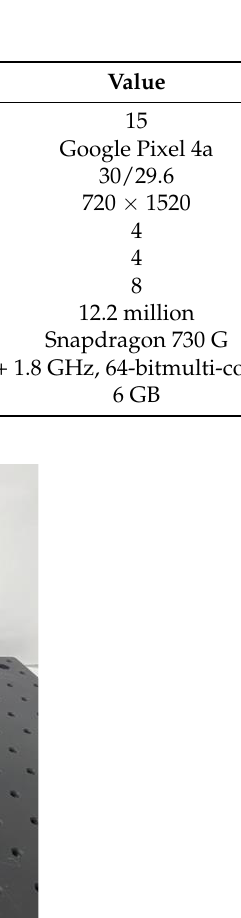
Table 1. Configurations of the VLC system.